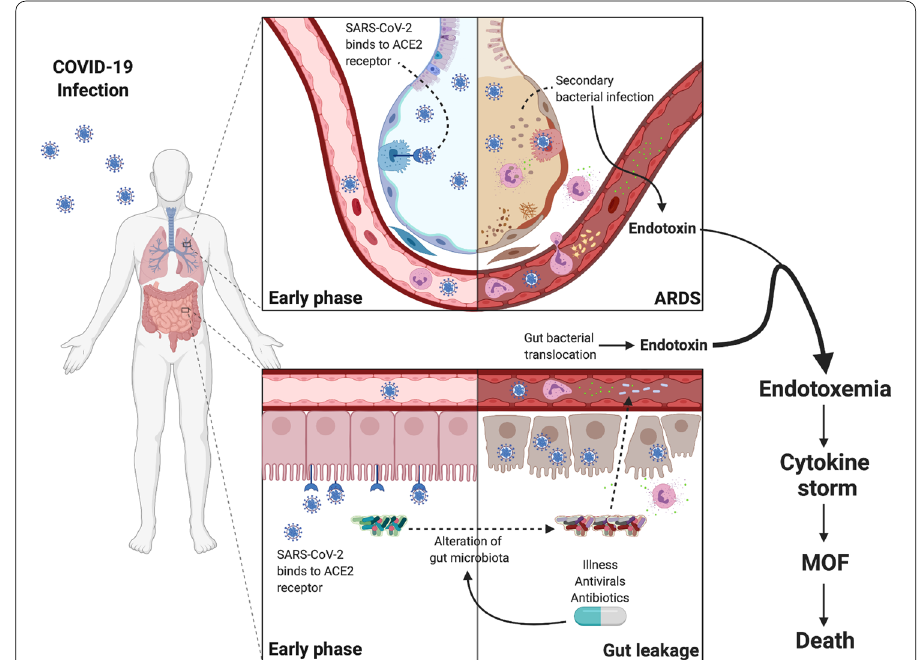
Fig. 6 Hypothetical pathogenesis of endotoxemia in COVID‑19 pneumonia. At early stage, SARS‑CoV‑2 primarily infects type 2 pneumocytes in the lungs and causes pneumonia which can progress to ARDS and induces susceptibility of secondary bacterial infection by impairing the pulmonary immune response. The virus can enter the bloodstream causing viremia targeting organs with high ACE2 expression including the gut. SARS‑CoV‑2 infection of enterocytes causes inflammatory response of gastrointestinal tract which results in alteration of the intestinal microenvironment including epithelial hyperpermeability, attenuated local immune system, and dysbiosis of the microbiome. The perturbations of the intestinal microenvironment allow the pathogenic bacteria from the gut lumen to translocate to the bloodstream. Hence, we propose the sources of endotoxin to be majorly from the gut and minorly from the secondary bacterial infection of the lungs. COVID‑19, the coronavirus disease 2019; SAR‑CoV‑2, severe acute respiratory syndrome coronavirus 2; ARDS, acute respiratory distress syndrome; ACE2, angiotensin converting enzyme 2; MOF, multiple organ